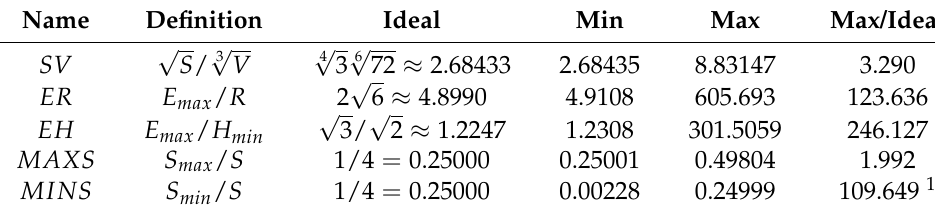
Table 7. Mesh quality of the real 3D model after optimization with TetGen program.